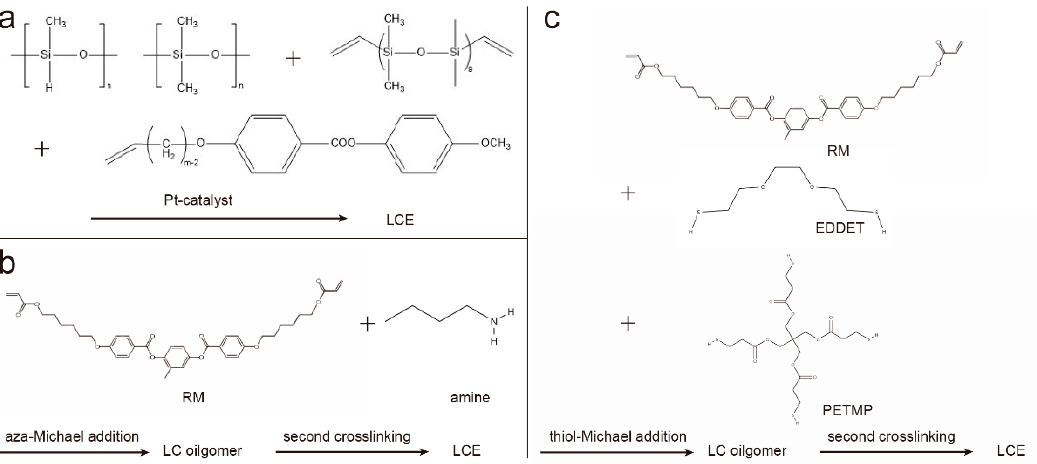
Figure 2. Synthetic route for two-step cross-linked LCE chemistry. ( a ) Two-step crosslinking by hydrosilylation; ( b ) aza-Michael addition between diacrylate-based RMs and amines; ( c ) thiol-Michael addition of diacrylate-based RMs and thiols.